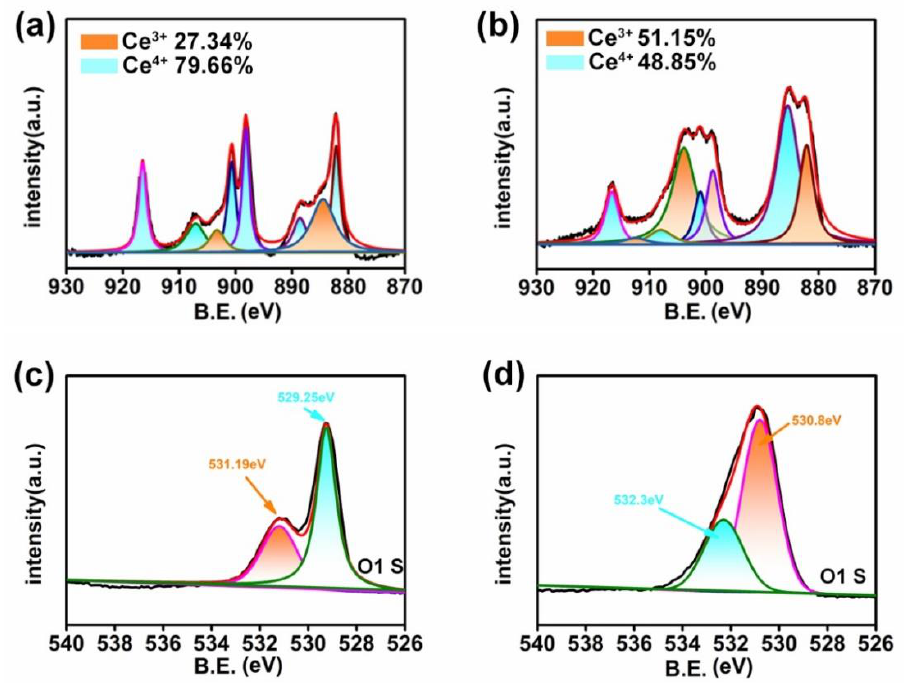
Figure 2. The Ce 3d XPS patterns of CeO 2 ( a ), CeAY ( b ) and the O1s patterns of CeO 2 ( c ), CeAY ( d ). The survey spectrum of CeAY in Figure S3b show the presence of Mg, Na, Ce, O, and Si. As depicted in Figure 2b, after the CeO 2 was added to the acid clay, four peaks at 916.65 eV, 908 eV, 901 eV, and 898.78 eV were detected, which can be specified as the binding energies of Ce 3d 5/2 and Ce 3d 3/2 of Ce 4+ [44-46]. Compared with Figure 2a,